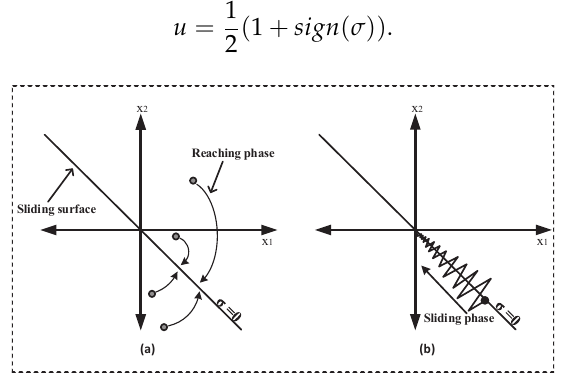
Figure 3. State space trajectories under Sliding Mode Control (SMC). ( a ) reaching phase; ( b ) sliding